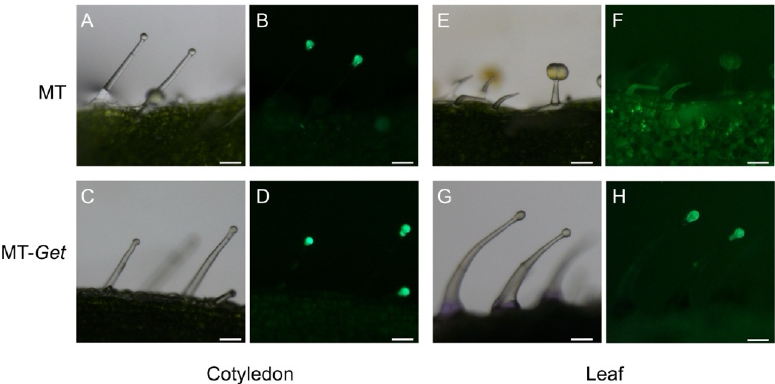
Figure 3. p SlAT2::GFP expression (green fluorescence: 480/505 nm excitation/emission spectra) at the tip cells of MT and MT- Get type-IV trichomes on the cotyledons (an organ from the juvenile phase) of MT ( A , B ) and MT- Get ( C , D ); and on the fifth leaf (an organ from the adult phase) of MT ( E , F ) and MT- Get ( G , H ). Scale bar = 100 μ m.